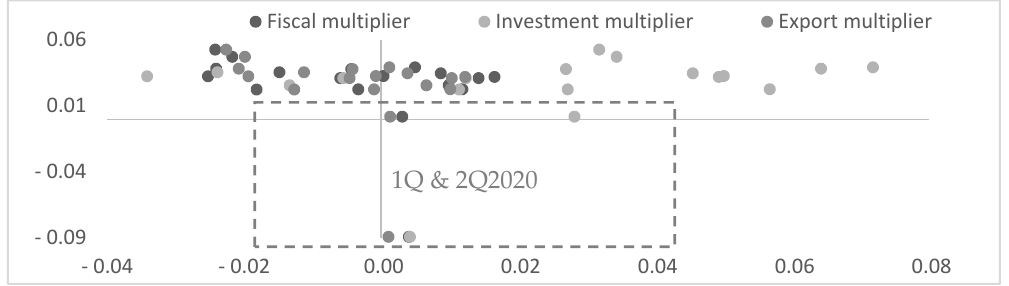
Figure 10. Changes in autonomous expenditure multipliers and GDP—Germany, own work, source: Eurostat.